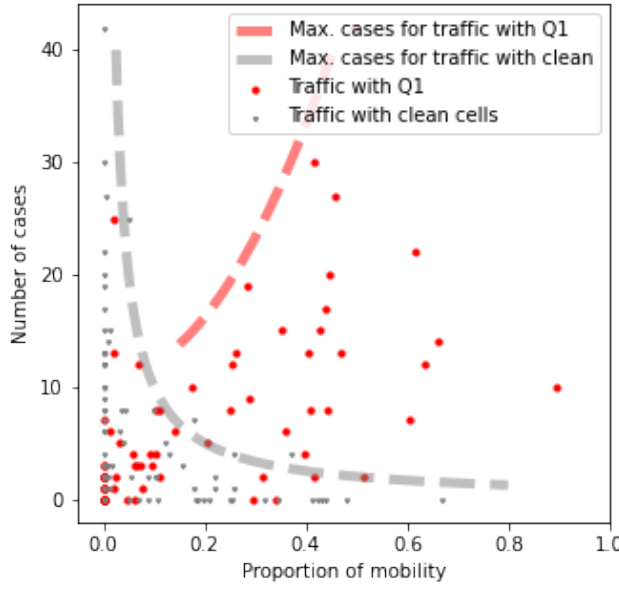
Figure 6. Traffic profiles of all the